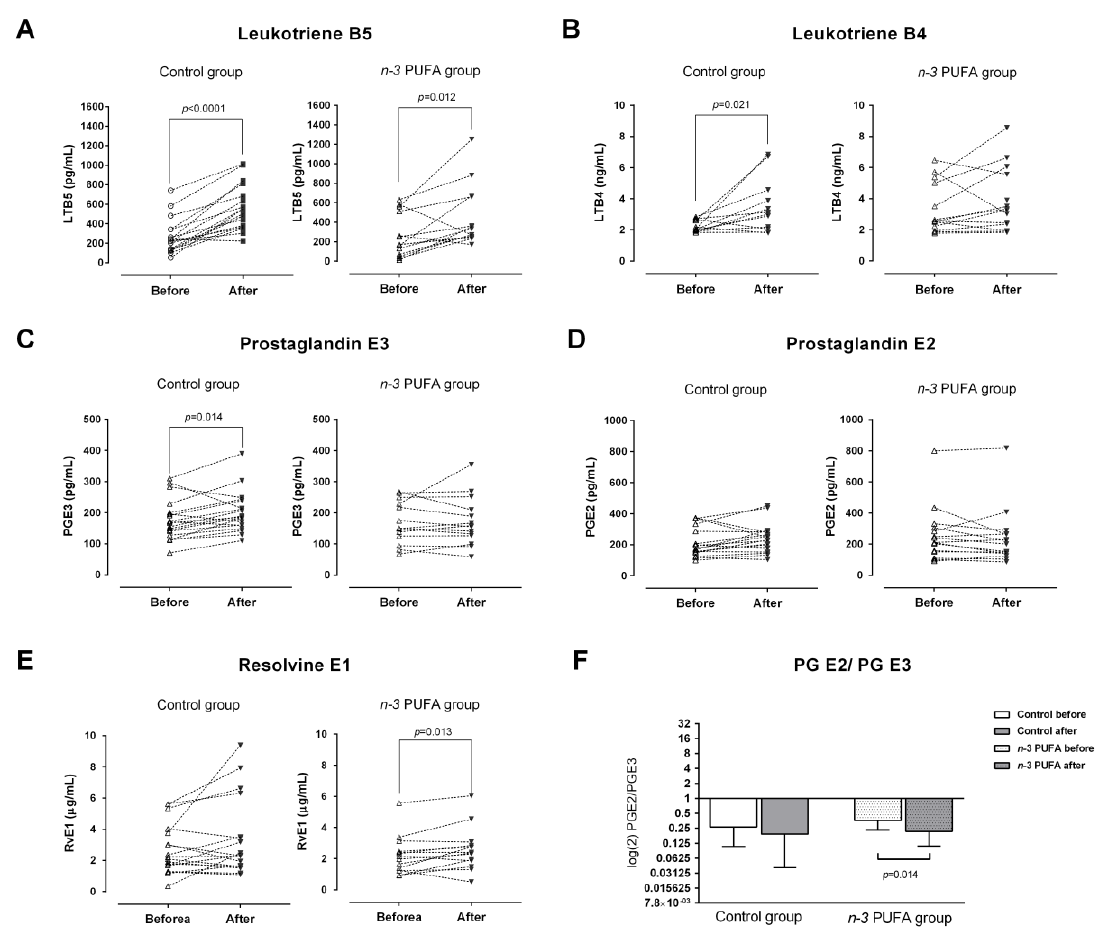
Figure 2. Effects of regular (control group) and n -3 polyunsaturated acid (PUFA)-enriched hen egg ( n -3 PUFA group) consumption on the serum concentrations of pro-inflammatory leukotriene B4 ( B ) and prostaglandin E2 ( D ); inflammation resolving leukotriene B5 ( A ), prostaglandin E3 ( C ) and resolvin E ( E ) lipid mediators originating from n -6 (arachidonic acid; AA) and n -3 (eicosapentaenoic acid; EPA) fatty acids. The ratio between prostaglandin E2 and prostaglandin E3 is shown at Panel ( F ). PUFA—polyunsaturated fatty acid; LTB4 – leukotriene B4; LTB5—leukotriene B5; PGE2 - prostaglandin E2; PGE3—prostaglandin E3; RvE1—resolvin E1. Paired t -test; significance level p < 0.05; before protocol vs. after protocol.